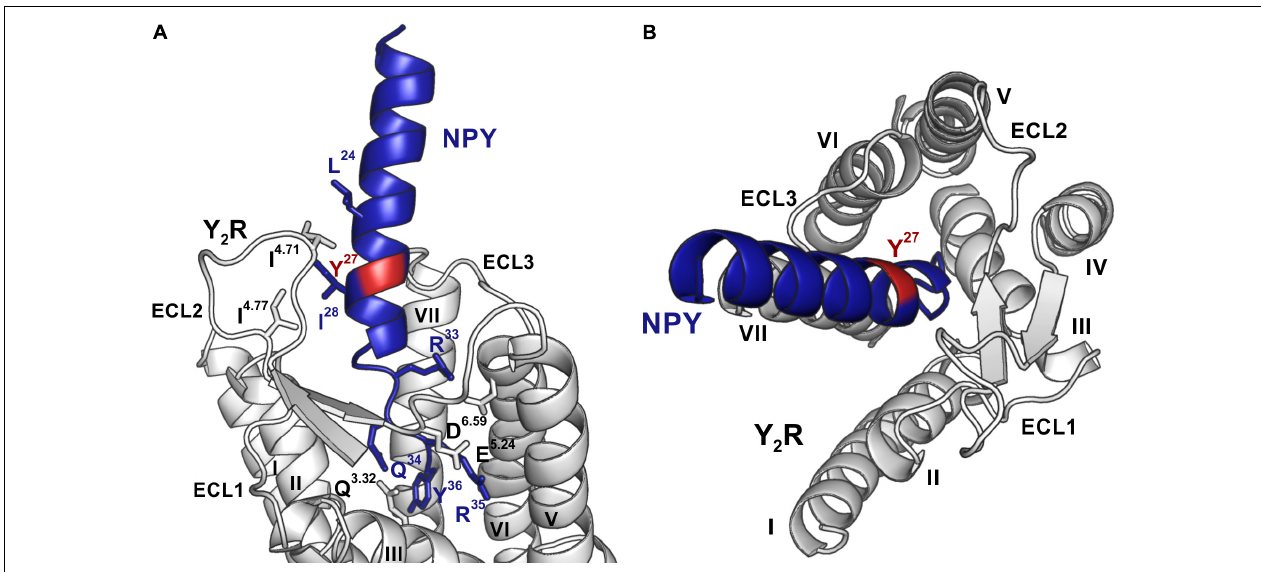
FIGURE 5 | Model of NPY bound to Y 2 R, modified from Kaiser et al. (2015). Position 27, which was used for introduction of the photo-crosslinker, is highlighted in red, NPY is shown in blue and Y 2 R in gray. (A) The C-terminus of NPY unwinds upon binding to the TM helix bundle, while I 24 and I 28 of NPY form hydrophobic contact toward the ECL2 of Y 2 R. The side-chains of residues involved in binding are shown in the respective colors and are labeled. (B) NPY has a steep binding mode, as viewed from the top, with the C-terminus of NPY binding deep inside the TM helix bundle. ECL, extracellular loop; TM,